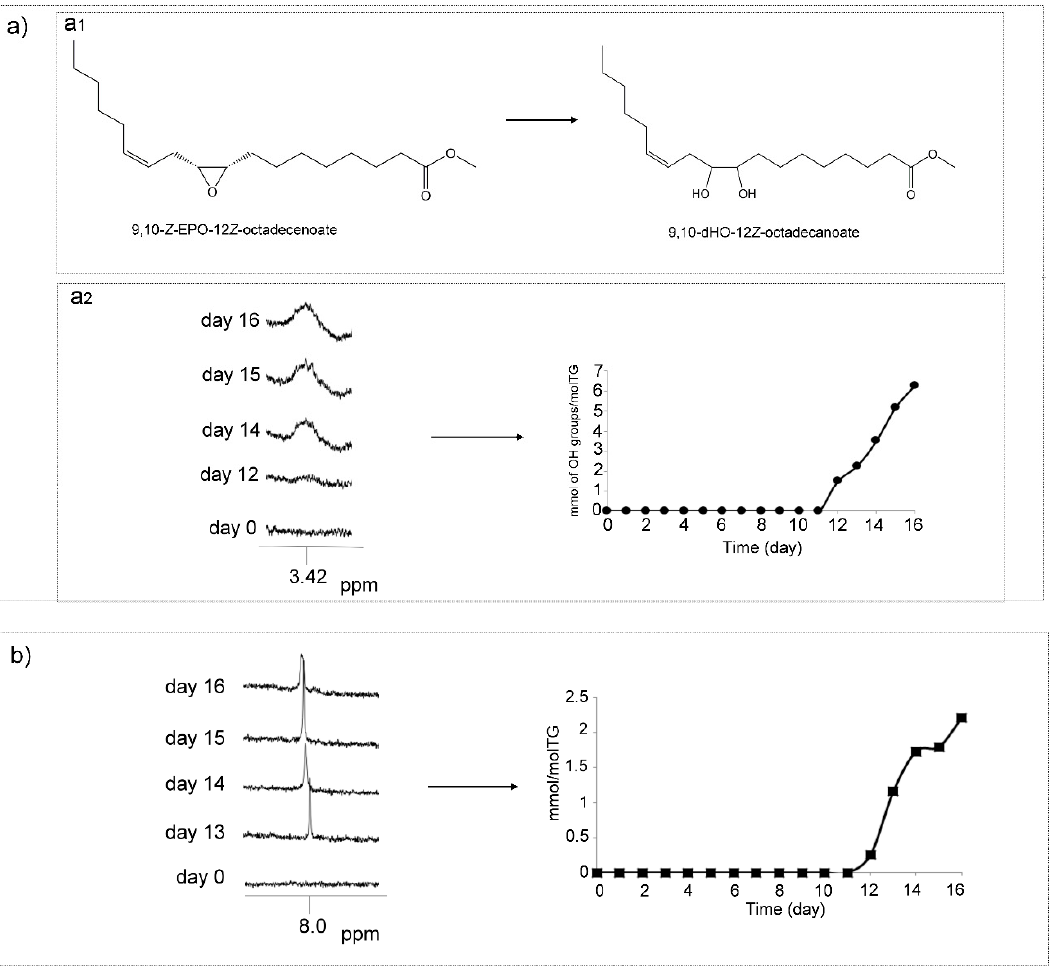
Figure 12. ( a ),( a 1 ) Formation pathway of dihydroxy monoenes (dHO-mEs) proposed by some